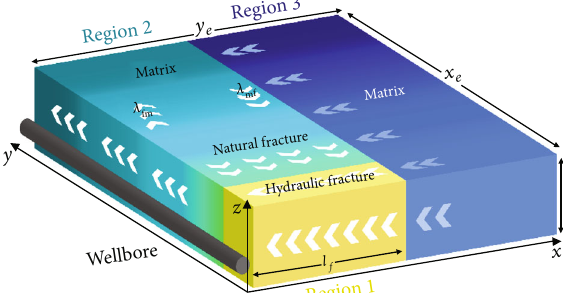
Figure 1: Schematic of segment of a horizontal well associated with one stage of hydraulic fracturing. The 3-region con fi guration is used for generating the fractal multiple porosity media model considered in this